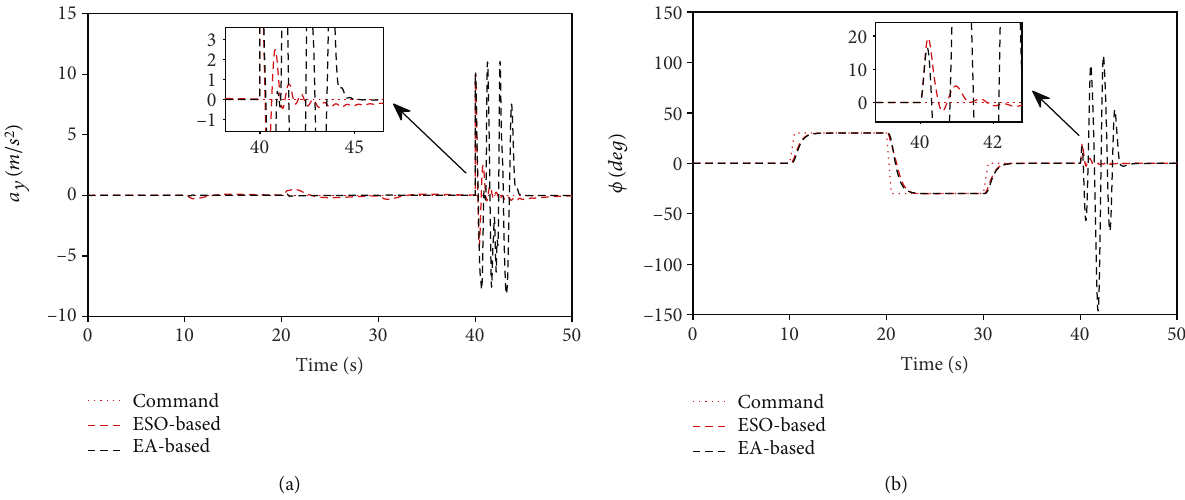
Figure 17: Simulation results with wind disturbance. (a) Lateral acceleration response. (b) Bank angle